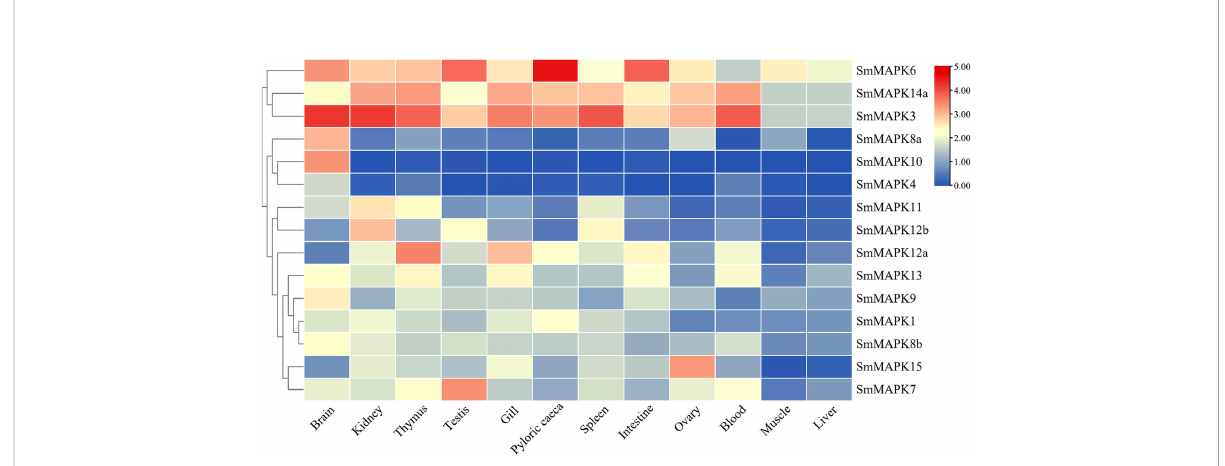
FIGURE 4 Heat map of mitogen-activated protein kinase (MAPK) expression in 12 different tissues in S. maximus . Each cell with a different color corresponds to a different expression level, which was normalized into log 2 (RPKM + 1).